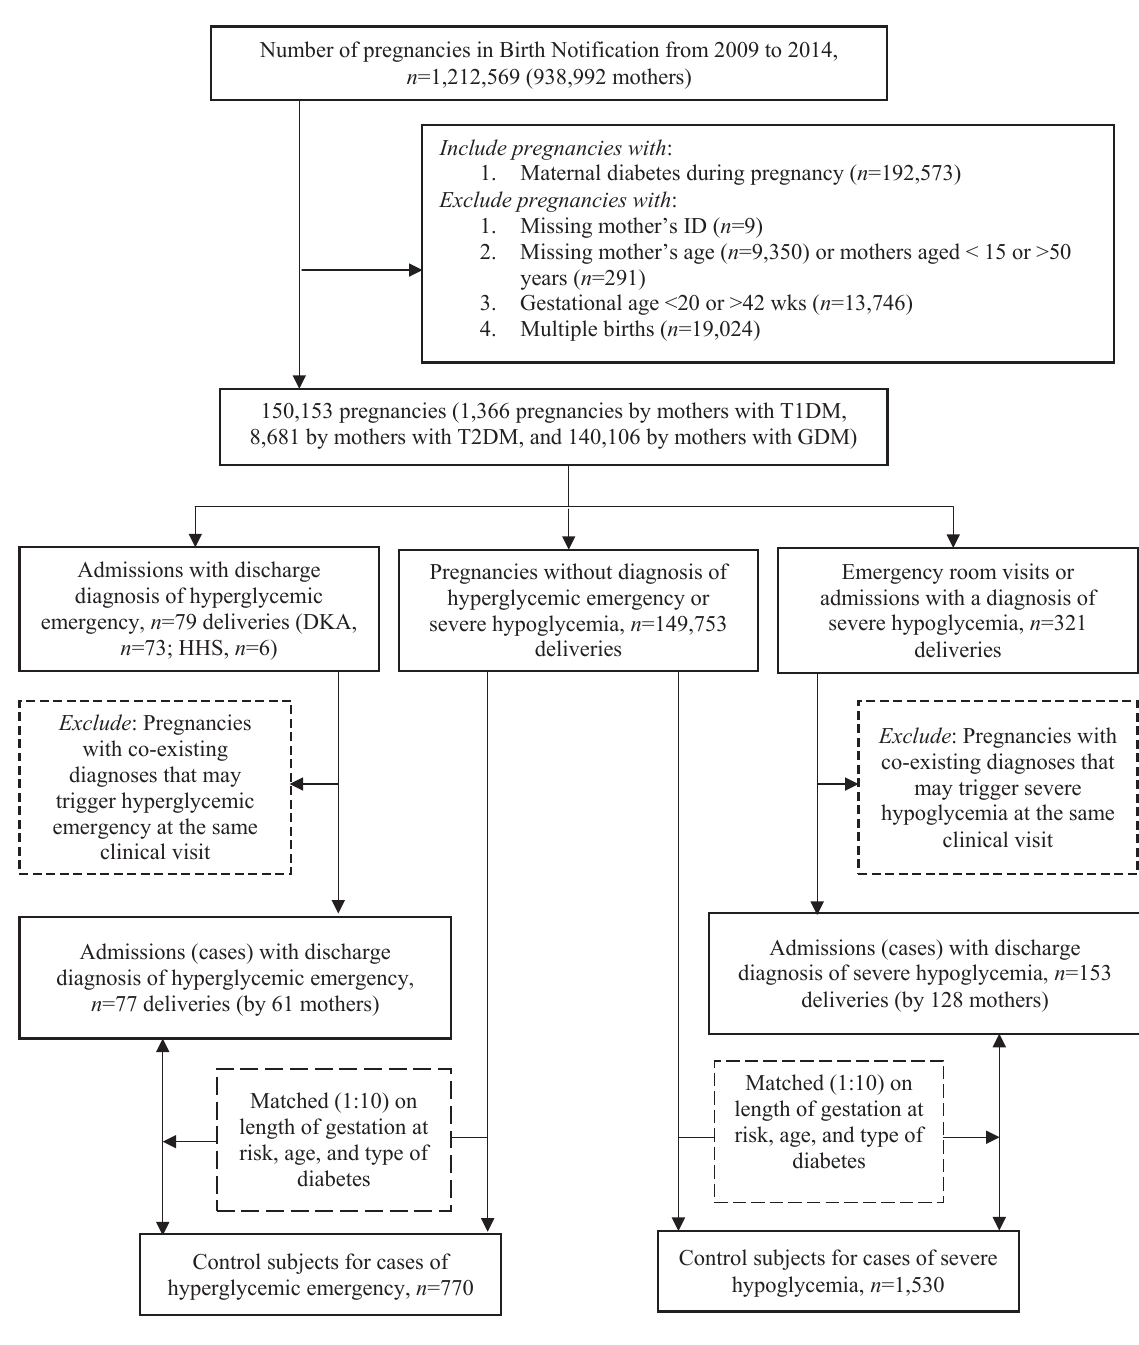
Fig. 1 Flow chart of enrolling cases and